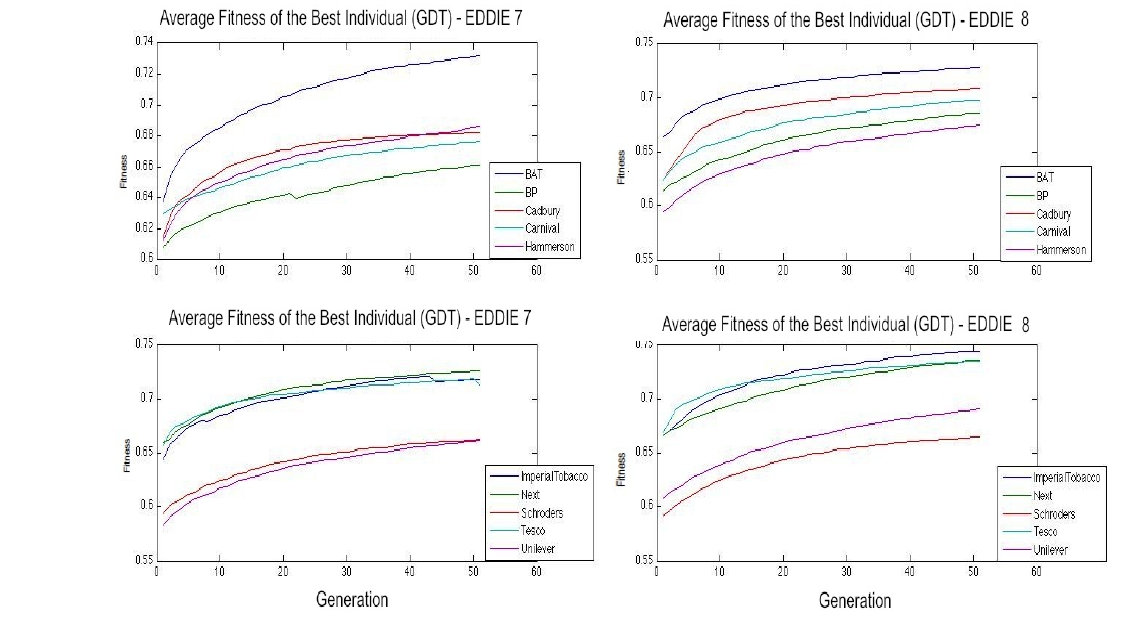
Figure 5 Average Best Fit . We first obtain the best GDT’s fitness per generation, for each one of the 50 runs. This happens for both algorithms. We then calculate the average of these fitness values (over the 50 runs) and present them in this figure. For the convenience of the reader, we have split the stocks into 5 per graph (by alphabetical order). The graphs in the first column are for EDDIE 7 and the others for EDDIE